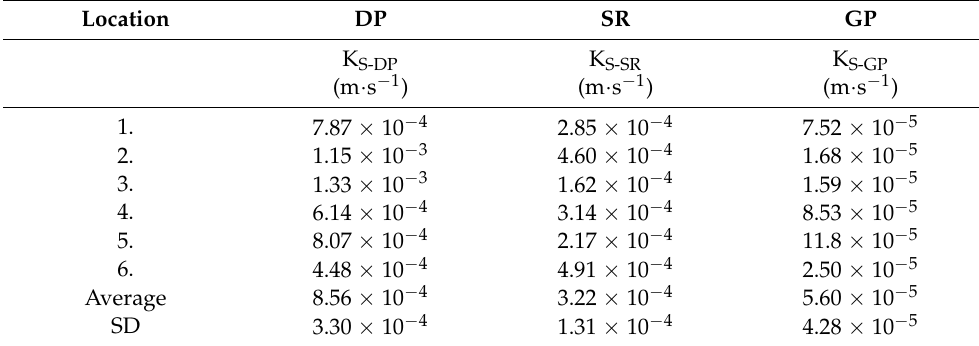
Table 2. Hydraulic conductivity of the forest floor determined by three different methods with average and standard deviation (SD) values.